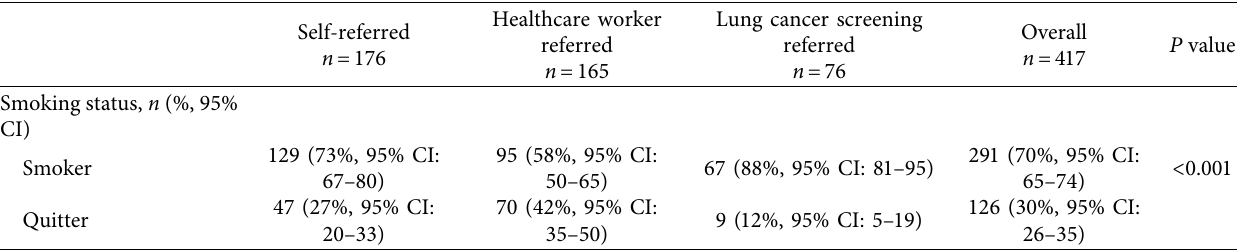
Table 3: Smoking status of participants at 6